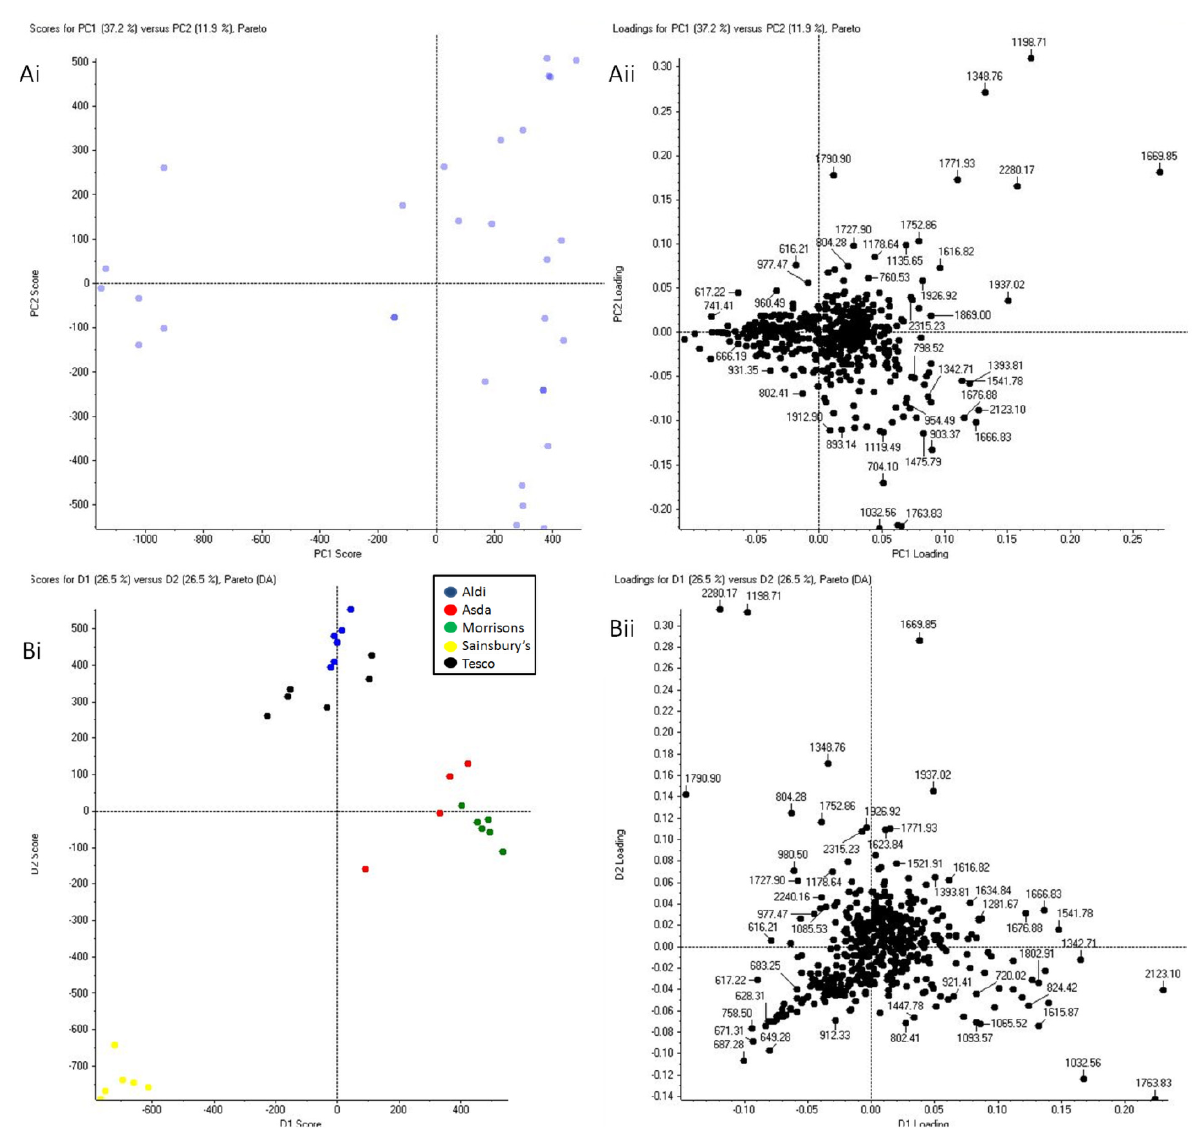
Figure 6. Principal component analysis of bovine blood collected from raw packaged meat (from five supermarkets in total: Asda, Aldi, Morrison’s, Tesco, and Sainsbury’s). Six replicate spectra from each in solution packaged bovine blood proteolysis were used for the statistical analysis. Panels ( Ai , Aii ) are the unsupervised PCA plots; Panels ( Bi , Bii ) are the supervised PCA-DA plots with blood provenance grouping based on supermarket of origin.